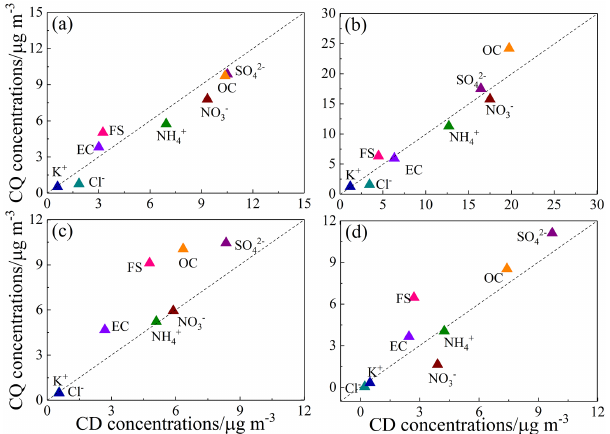
Figure 4. Seasonal mean concentrations of major components in autumn (a) , winter (b) , spring (c) , and summer (d) at CD and CQ